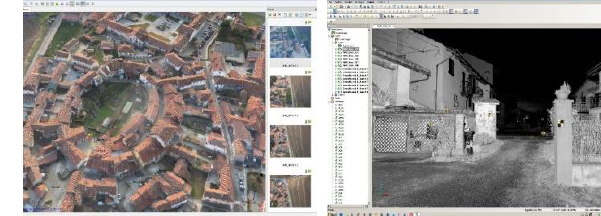
Figure 17. Images from the raw data: the point cloud from UAV photogrammetry, and TLS